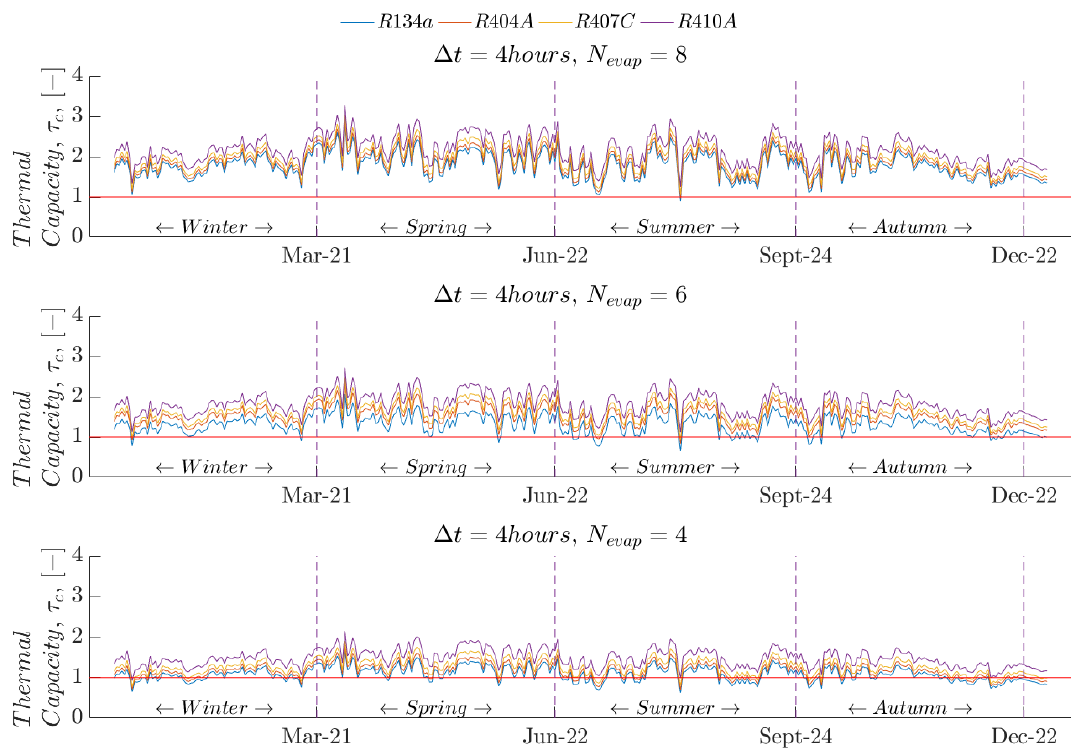
Figure 7. Thermal capacity of the heat pump during the year for all refrigerants, working 4 hours.